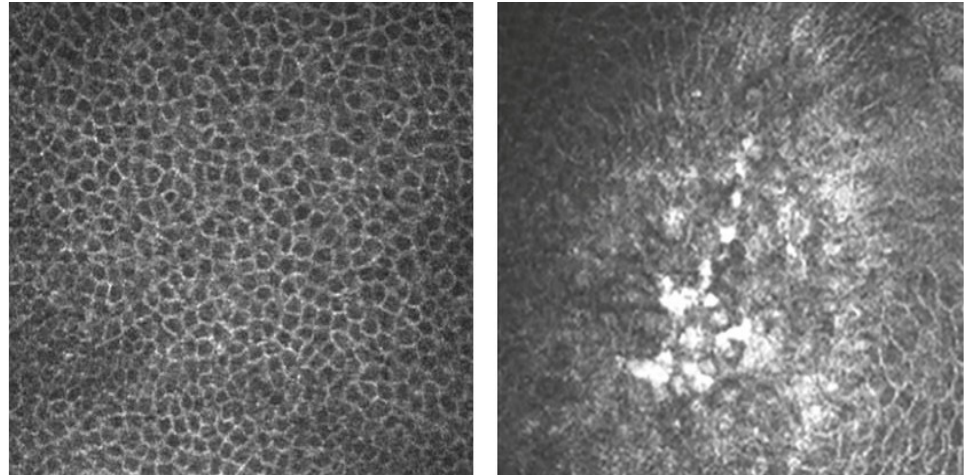
Figure 2. In vivo confocal microscopy of a normal human cornea observed at the basal epithelium ( left ); swollen and necrotic epithelial cells during active herpes simplex keratitis ( right ). The authors, using histopathologic sections of HSV-infected specimens as a term of comparison, hypothesized that these cells may represent HSV-infected cells, such as